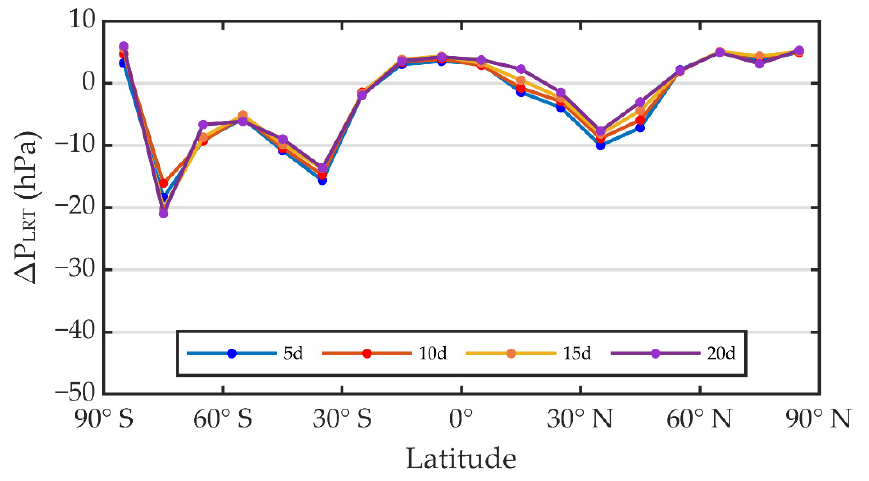
Figure A1. Latitudinal variation in monthly P LRT difference ( ∆ P LRT , in hPa) between NCEP/NCAR reanalysis and radiosonde data averaged over 1980–2017. The monthly radiosonde P LRT is calculated with different thresholds that requires at least 5, 10, 15, or 20 days with available daily radiosonde P LRT in a month. The data showed is the 10°-zonal mean.